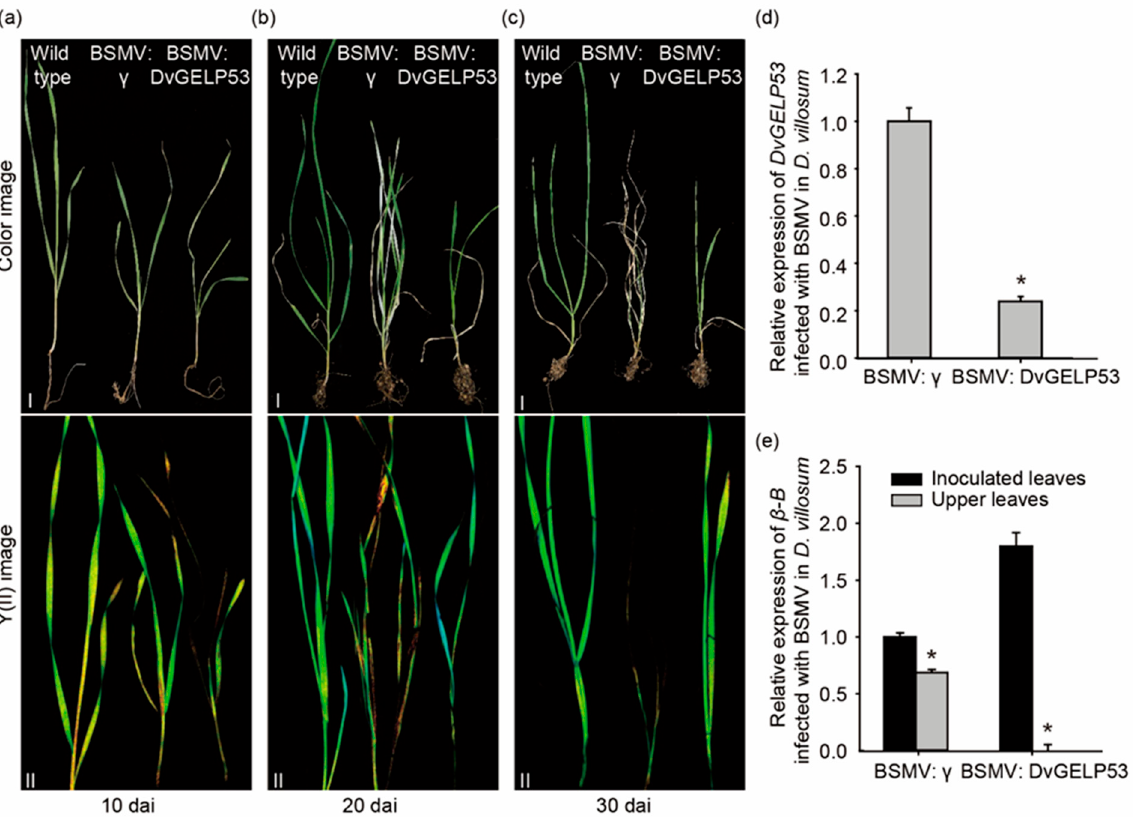
Figure 7. Functional analysis of DvGELP53 by virus-induced gene silencing (VIGS). D. villosum leaves of the seedlings inoculated with BSMV: γ or BSMV:DvGELP53 at 10 days after inoculation (dai) ( a ), 20 dai ( b ) and 30 dai ( c ). Successful virus infection in D. villosum was verified by detecting the chlorotic mosaic phenotype on the leaves; (I) and (II) represent visual observation and false-color images of Y(II) measurements at different inoculation times, respectively. Wild type and BSMV: γ were control. ( d ) Expression levels of DvGELP53 in the BSMV: γ and BSMV:DvGELP53 plants. The BSMV: γ is set to 1. ( e ) Expression levels of β -B (from the BSMV genome) in inoculated leaves and upper leaves of D. villosum at 20 dai. Each point represents the mean of three replicates. Bars indicate the standard error (SE), and * show significant differences at p < 0.05.